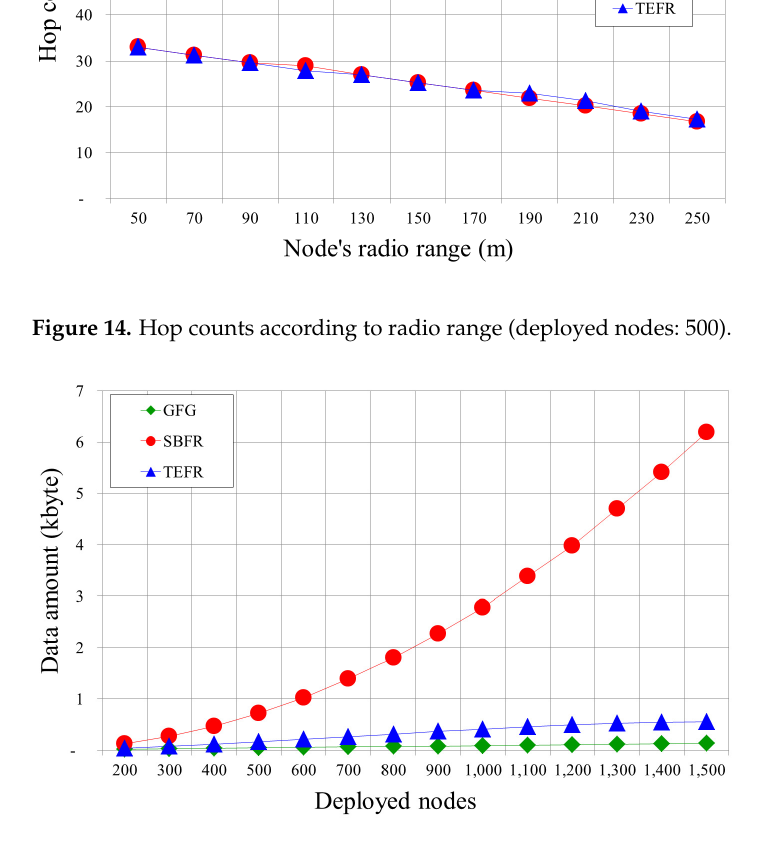
Figure 15. The quantity of transferred location information according to the number of nodes (radio range: 100